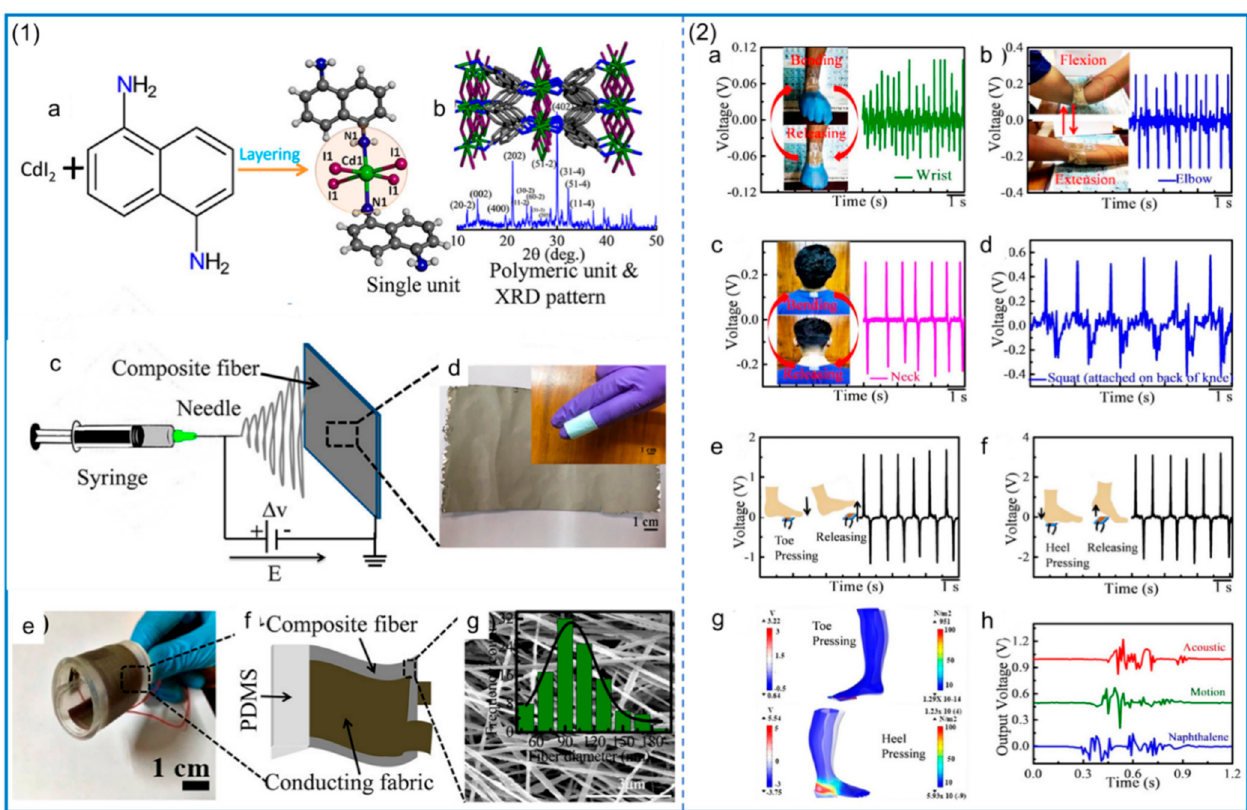
Figure 7. ( 1 ) The macroscopic and microscopic structure and state diagram of the material, ( a ) the schematic diagram of the synthesis route of two-dimensional MOF (CdI 2 − NAP) and its unit structure. ( b ) MOF structure (top), XRD (bottom). ( c , d ) electrospinning. ( e , f ) photos of C − PNG. ( g ) FE-SEM images of composite NFs, inset shows a histogram of fiber diameter distribution. Reprinted with permission from Ref. [126], copyright 2021, American Chemical Society. ( 2 ) Analysis of piezoelectric properties during human movement, ( a ) voltage responses of C − PNGs attached to a wrist, ( b ) elbow, ( c ) neck, ( d ) knee, ( e ) toe, and ( f ) heel movements, the arrows represent pressure and release. ( g ) Simulation based on FEM. ( h ) Voltage response curves of C − PNGs attached to the throat during “acoustic,” “motor,” and “naphthene” vocations. Reprinted with permission from Ref. [126], copyright 2021, American Chemical